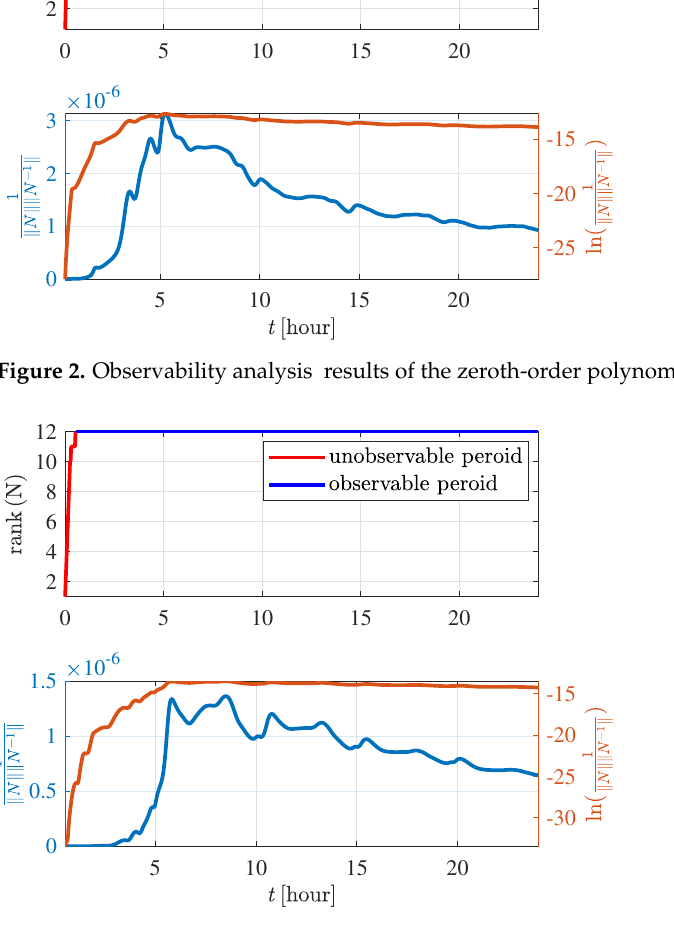
Figure 3. Observability analysis results of the first-order polynomial.